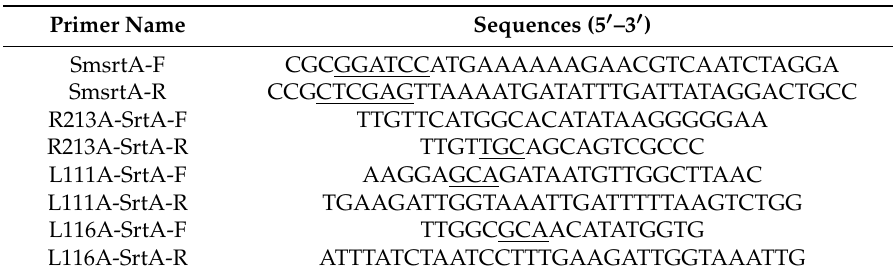
Table 1. Primers used in this